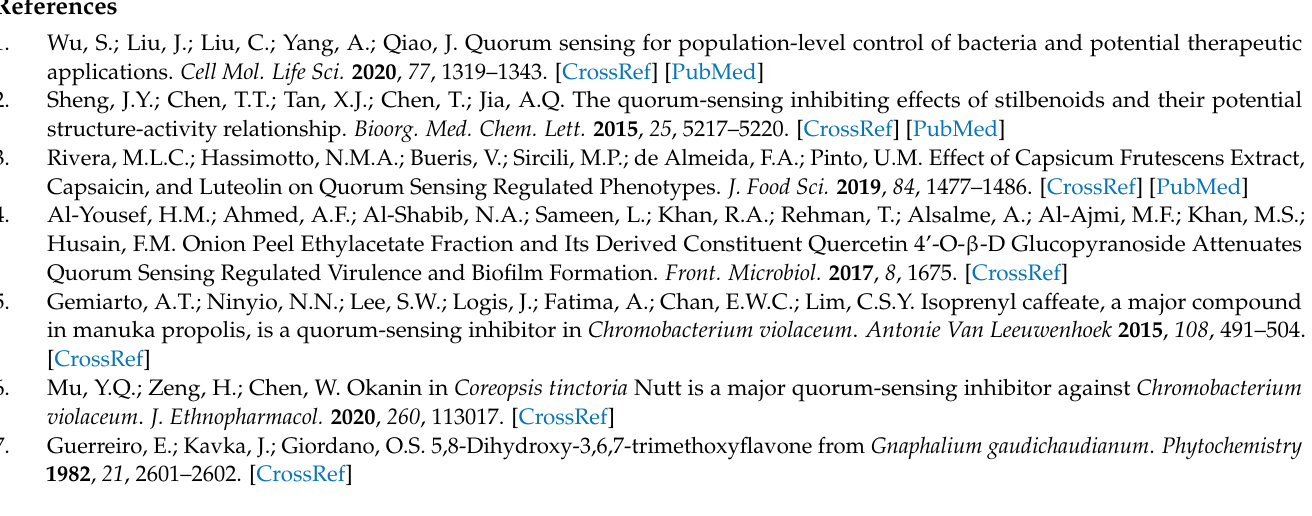
Table S4: Detailed data for calculations in molecular